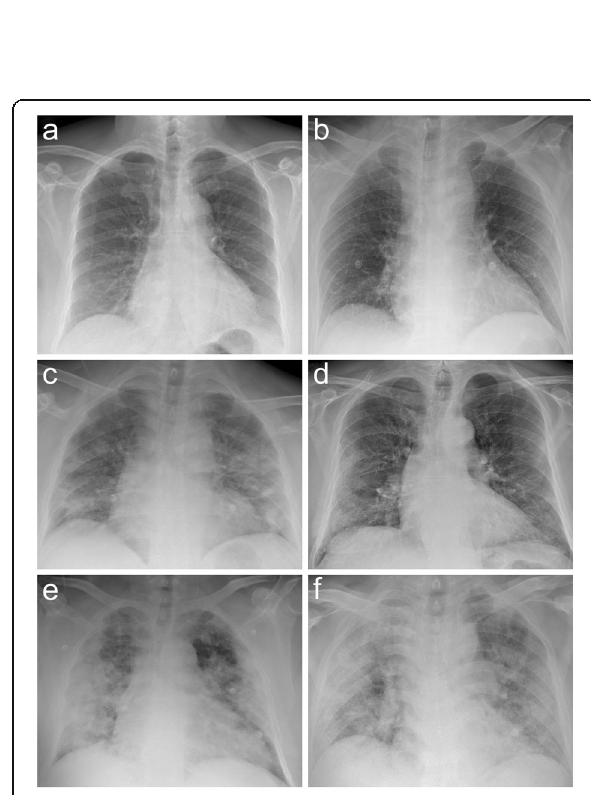
Fig. 2 CXR scoring in three COVID-19 patients with different degrees of lung parenchymal involvement. The CXR score for each patient was (upper zones R-L; middle zones R-L; lower zones R-L): a 0-0, 0-0, 1-1 (total 2); b 0-0, 2-2, 1-1 (total 6); c 1-1, 2-3, 2-3 (total 12); d 1-1, 2-2, 2-2 (total 10); e 2-2, 3-3, 3-3 (total 16); f 3-1, 3-3, 3-3